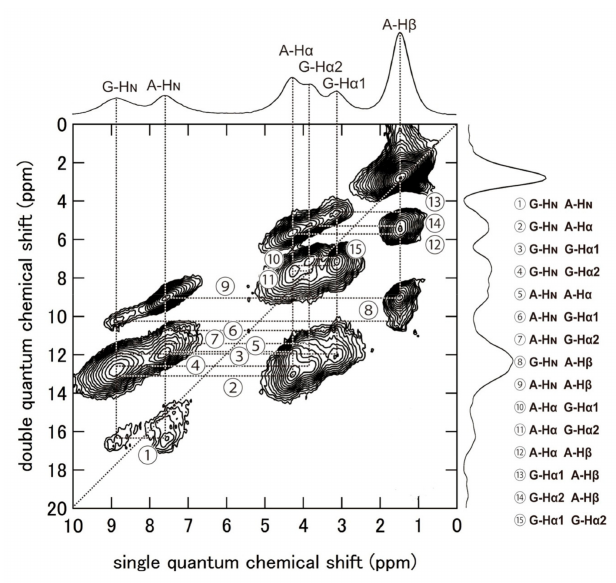
Figure 10. 2D 1 H (920 MHz) DQMAS NMR spectrum and the skyline projection of (AG) 15 with silk I structure together with assignments. The DQ correlations 1 (cid:13) – 15 (cid:13) are shown on the right-side [86]. Reprinted with permission from ref. 86. Modified from ref.